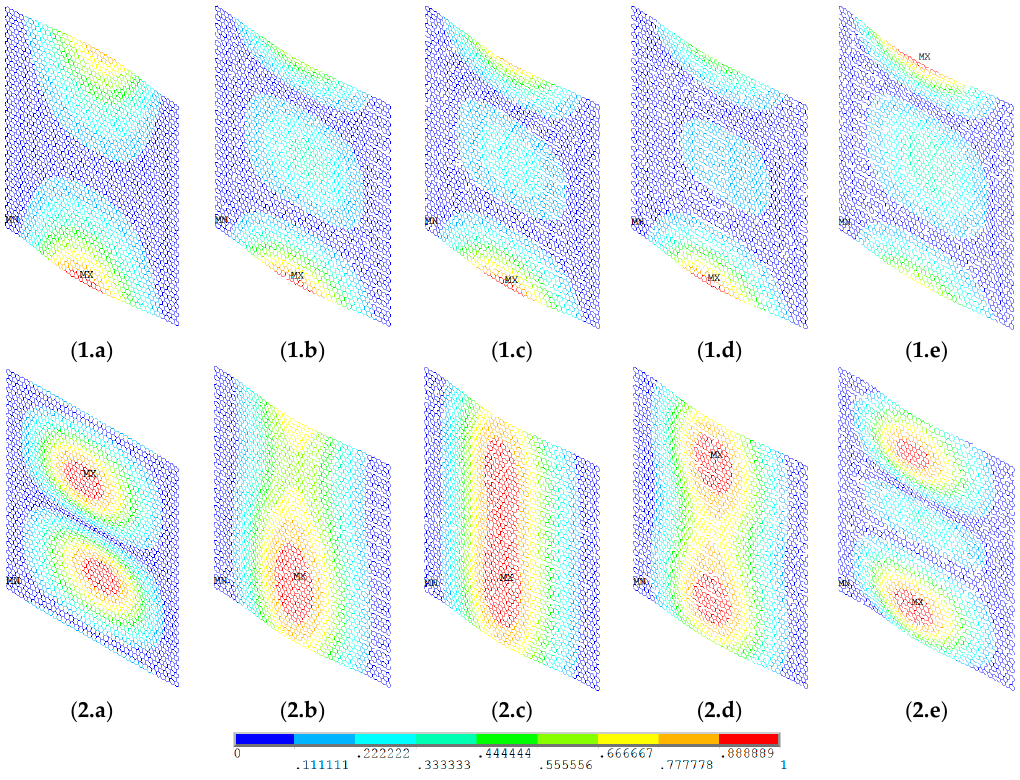
Figure 8. Vector sum of the displacement of graphene sheets. ( 1.a – 1.e ) First-order buckling mode; ( 2.a – 2.e ) fourth-order buckling mode; ( a – e ) 0%, 1%, 2%, 3%, and 4% of vacancy defects, respectively.